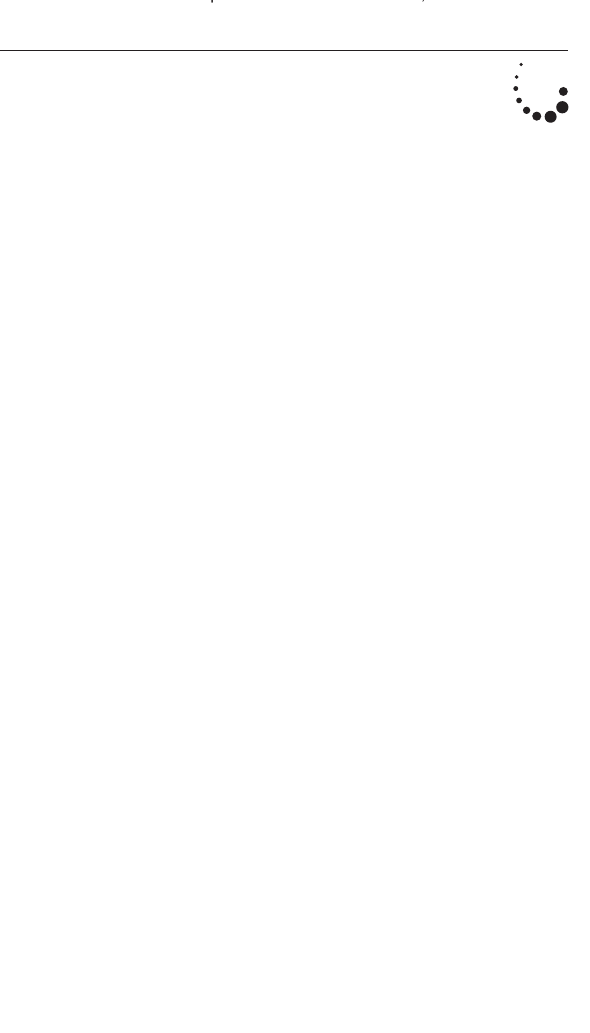
National and regional Equity Indices for University of KwaZulu- Natal staff Top and senior management 48.7 51.7 Middle management and